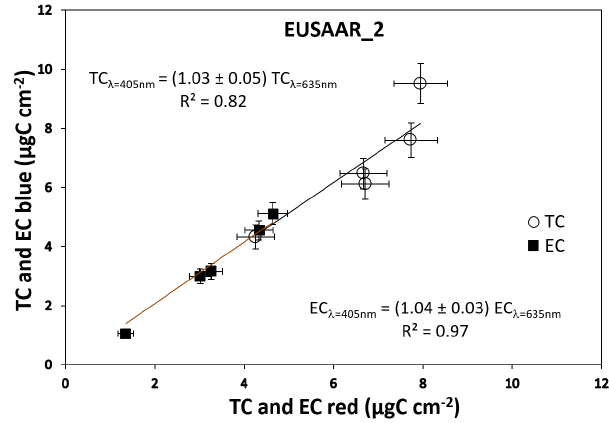
Figure 3. Quantification of TC and EC at λ = 635 (red) and λ = 405nm (blue) for the set of synthetic Aquadag + ammonium sulfate samples by the EUSAAR_2